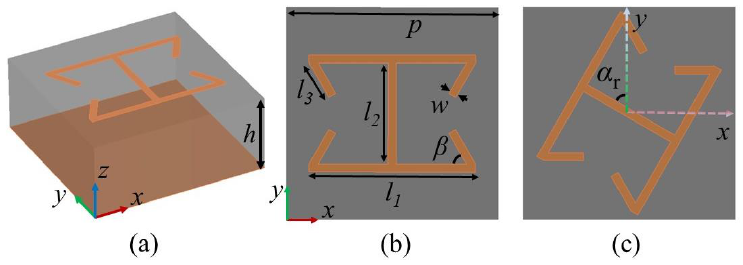
Figure 2. PB metasurface unit cell. ( a ) Perspective diagram. ( b ) Front view. ( c ) Rotating patch.